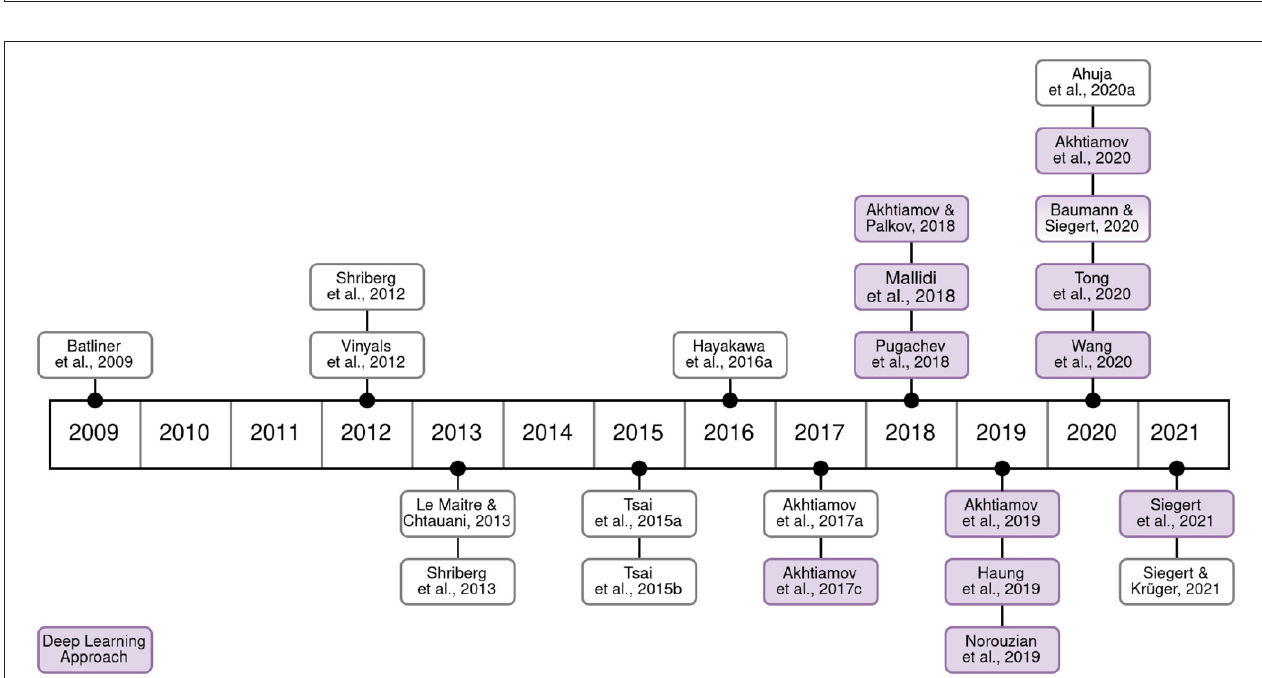
(2017a) and Akhtiamov and Palkov (2018) were extended with similar methods to before, but were employed on multiple diverse corpora, with the aim to establish a general baseline for further research in this